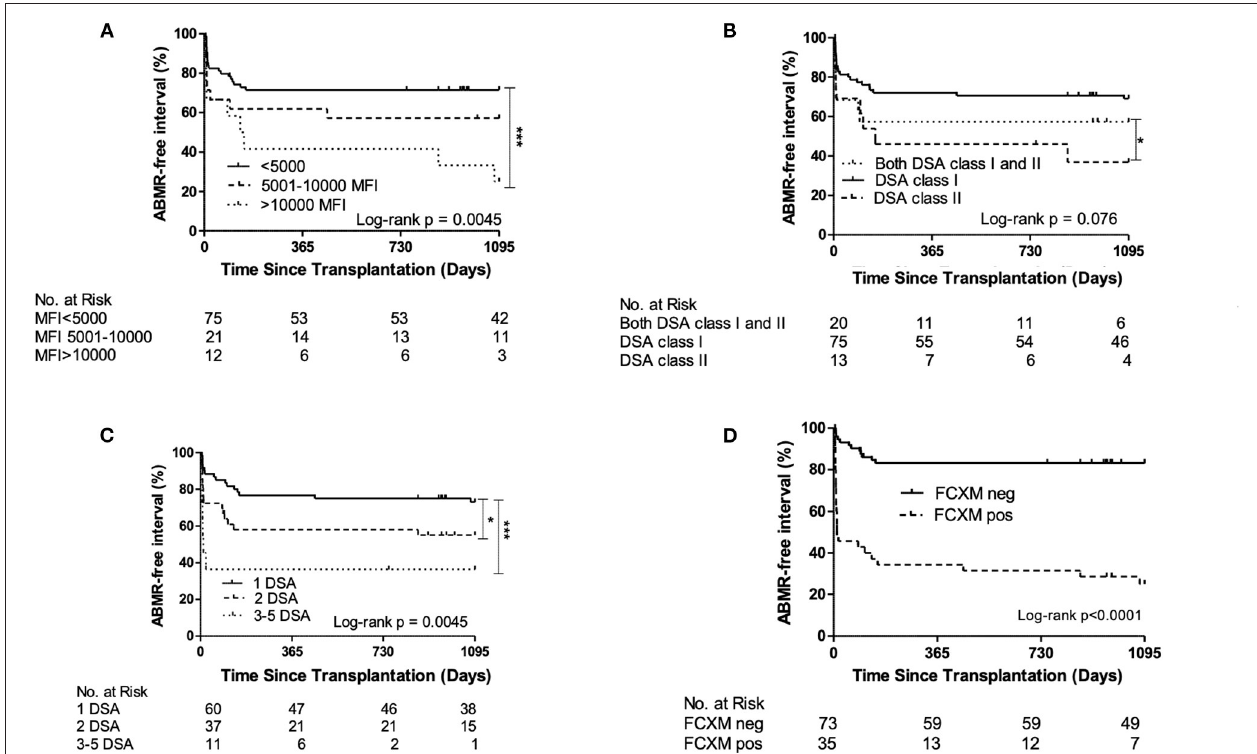
FIGURE 2 | Three-year death-censored antibody-mediated rejection (ABMR)-free interval displaying significantly higher incidence of ABMR in recipients with (A) donor-specific antibodies _(DSA) immunodominant mean fluorescence intensity (MFI) > 10,000, (B) DSA class II (C) higher DSA number and (D) patients with positive flow cytometry crossmatch (FCXM). * p < 0.05; *** p <